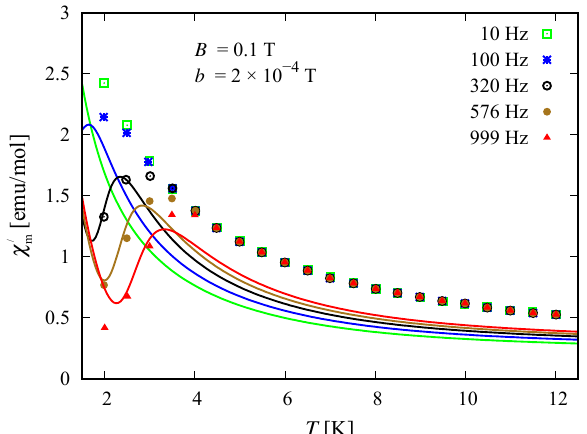
Figure 14. Temperature dependence of the in-phase susceptibility for the reduced compound [(Pc)Er{Pc{N(C 4 H 9 ) 2 } 8 }] − . The symbols and solid lines depict the experimental data from Reference [9] and the theoretical results, respectively. The computations are made with the aid of spin–sigma model (1) and (12). The values of all relevant parameters are provided in Table 5.